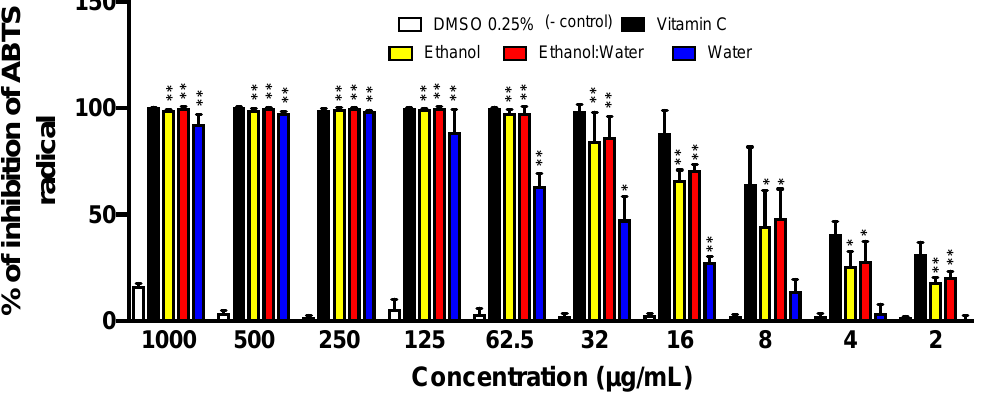
Figure 3. ABTS radical cation inhibition of three LT extracts at different concentrations (1000 µg/mL–2 µg/mL after 20 min incubation. The concentration of the ABTS was 100 µM. Each bar represents the average of three replicates and the error bars represent the standard deviation. The asterisks indicate a significant difference between the treatment and negative control (* p < 0.05 and ** p < 0.001).